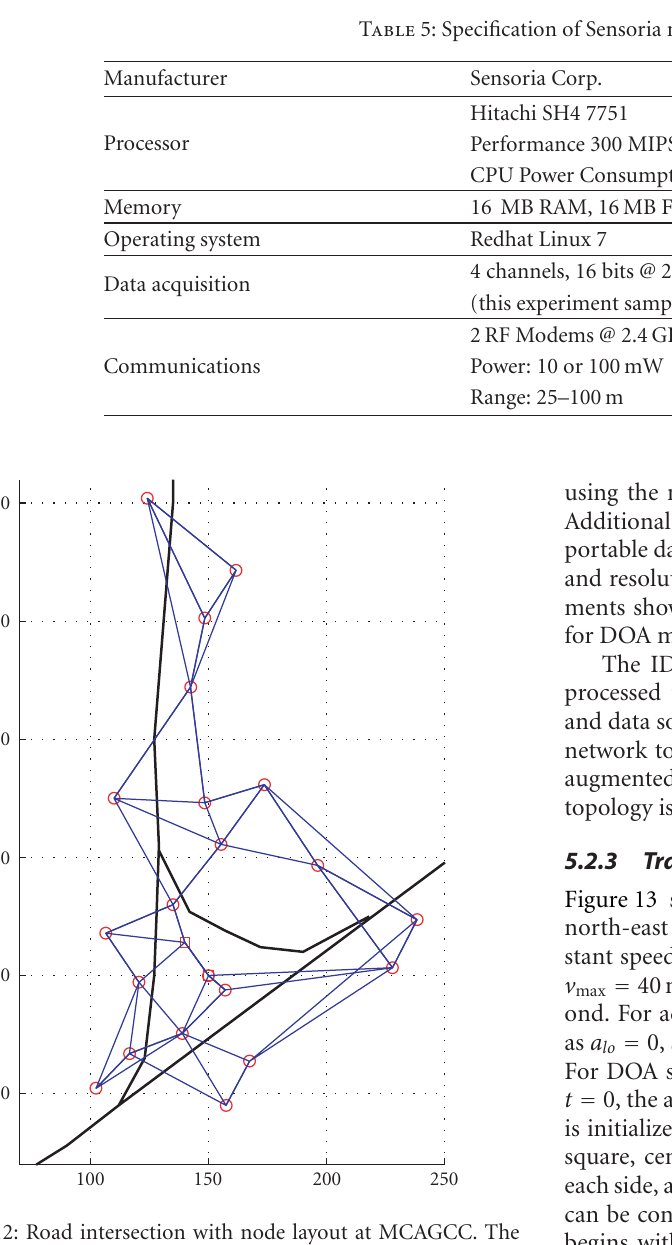
Figure 12: Road intersection with node layout at MCAGCC. The thick lines are the roads. The amplitude sensors are marked with a small circle, and the two DOA sensors (at (150, 150) and (140, 164)) are marked with small squares. The thin lines indicate the connec- tivity between